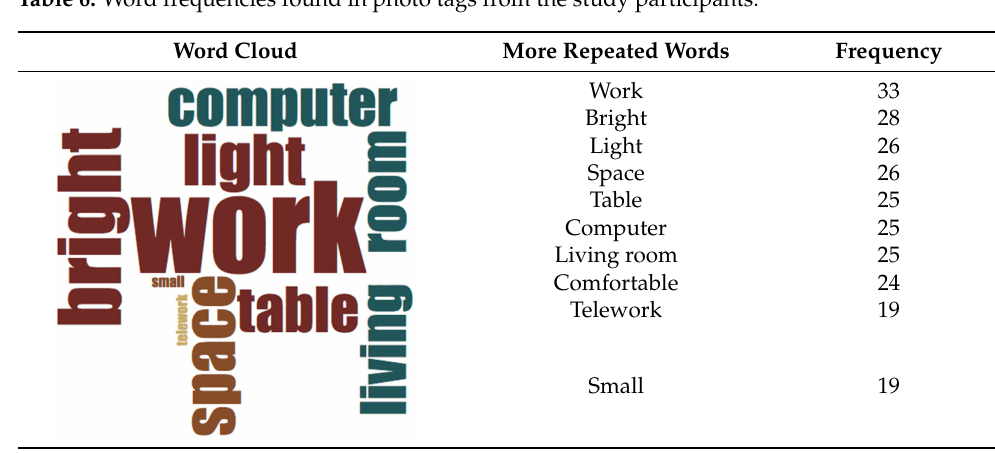
Table 6. Word frequencies found in photo tags from the study